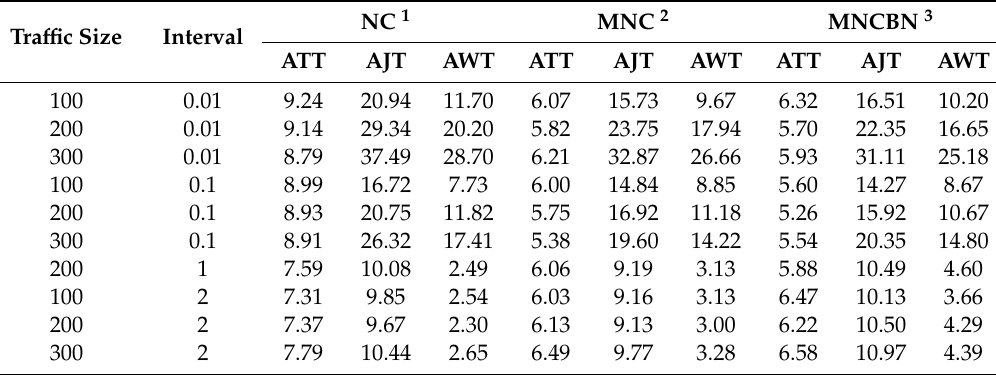
Table 3. Simulation results for the random interfloor tra ffi c